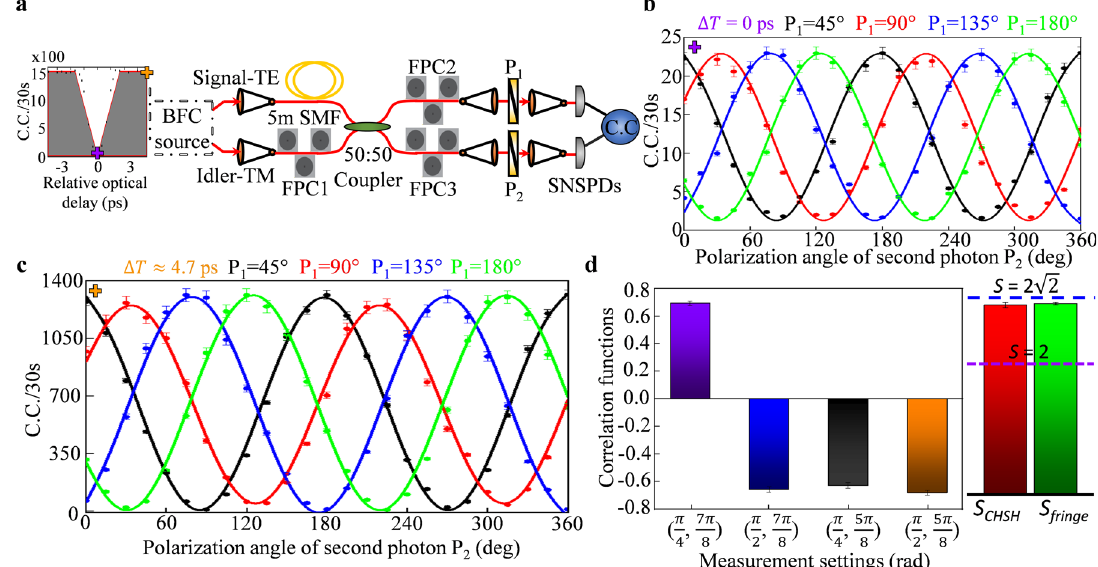
Fig. 3 Polarization hyperentanglement measurements of a high-dimensional 45.32 GHz BFC. a Illustrative experimental scheme in which the signal and idler photons from a 45.32 GHz BFC were sent to post-selected polarization entanglement measurements. The left inset of Fig. 1a is also included to indicate the frequency-polarization entanglement measurements after central HOM dip. The orange and purple marks indicate the position where the measurements are performed. P linear polarizer, C.C. coincidence counts. b Characterization of polarization entanglement at the central HOM dip with polarizer P 1 fi xed at 45° (black curve), 90° (red curve), 135° (blue curve), and 180° (green curve). In all cases, we measured the coincidence-counting rates at the two outputs while changing polarizer P 2 from 0° to 360°. In all four cases the measured fringes are well fi t with sinusoidal curves, having accidentals-subtracted mean visibilities of 89.98 ± 0.62%. c By setting the relative delay to 0.7 mm ( ≈ 4.7 ps) away from the central HOM dip position, we measured the polarization entanglement of our BFC. The measured fringes have accidentals-subtracted mean visibilities of 97.96 ± 0.41%. d Correlation values needed for the CHSH inequality, performed for results in panel c . The abscissa label ( φ 1 ; φ 2 ) denotes the measured polarization bases. The S CHSH parameter was calculated to be 2.686 ± 0.037 from these correlations, which violates the CHSH inequality by 18.5 standard deviations. We obtained the maximal achievable S fringe parameter to be 2.771 ± 0.016 from the mean visibility of the entanglement-correlation fringes. Purple and blue dashed lines denote the classical and quantum boundaries. Error bars represent statistical